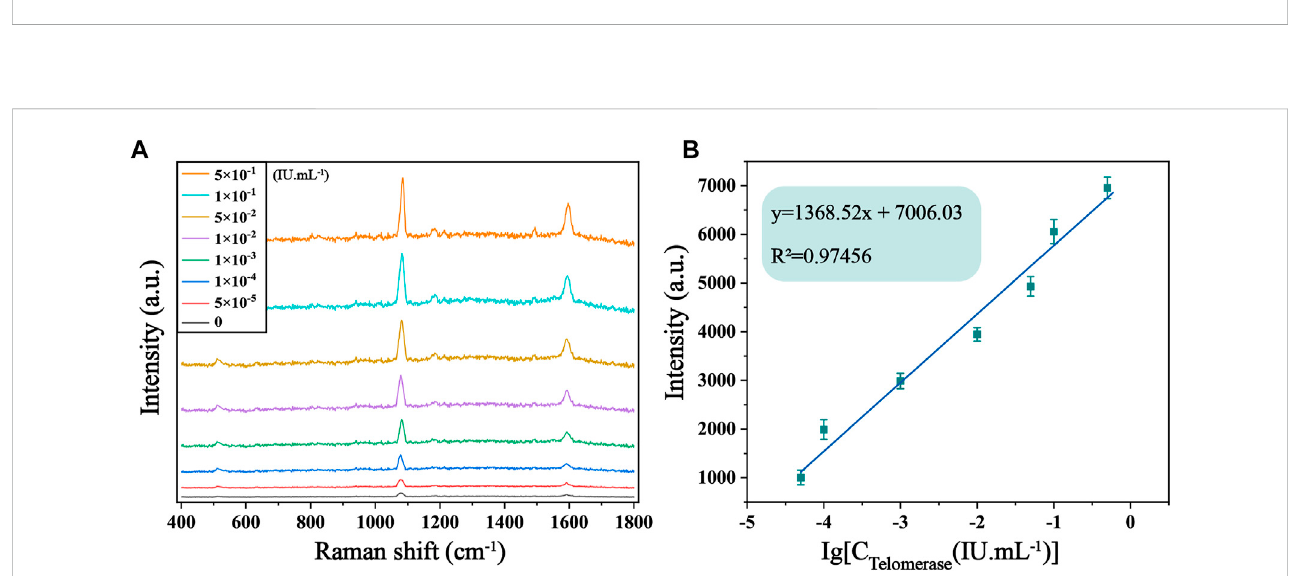
FIGURE 5 (A) SERSspectraof4-ATPinthepresenceoftelomeraseinnormalcelllysatesolutionwithdifferentconcentrations(0,5×10 − 5 ,1×10 − 4 ,1×10 − 3 ,1×10 − 2 , 5 × 10 − 2 , .1 and .5 IU/mL). (B) Corresponding calibration curves of SERS intensity at 1,592 cm − 1